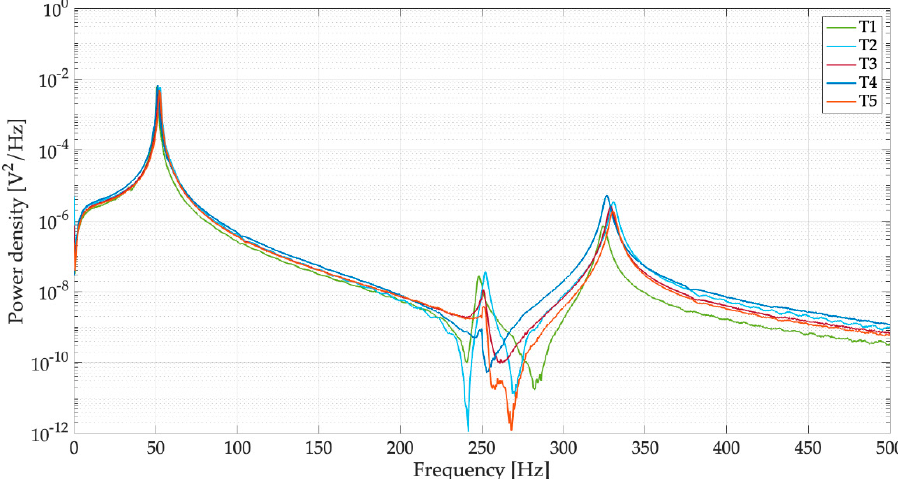
Figure 14. Tests with drops falling from 1 m on the empty spoon, PSDs of open-circuit voltage.